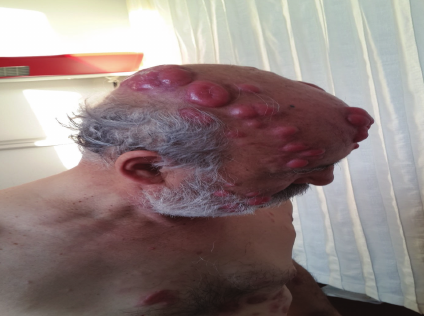
Figure 1: Prior to salvage treatment.